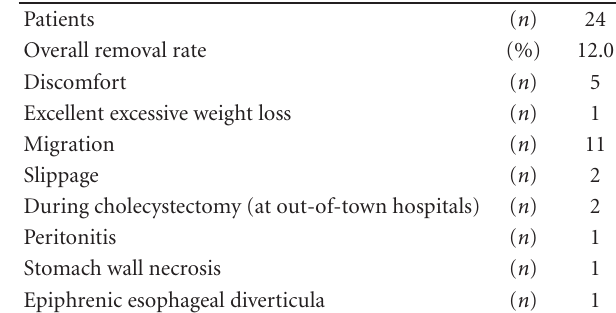
Table 3: Reasons for band